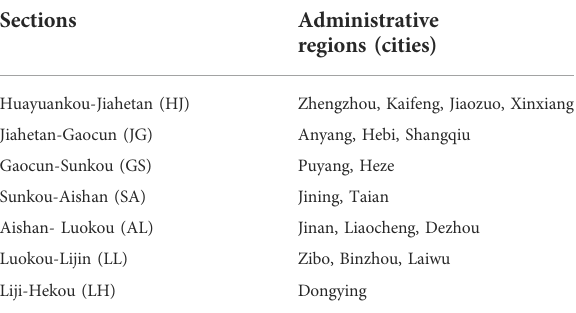
TABLE 1 Comparison table of generalized administrative units in the lower Yellow River. Sections Administrative regions